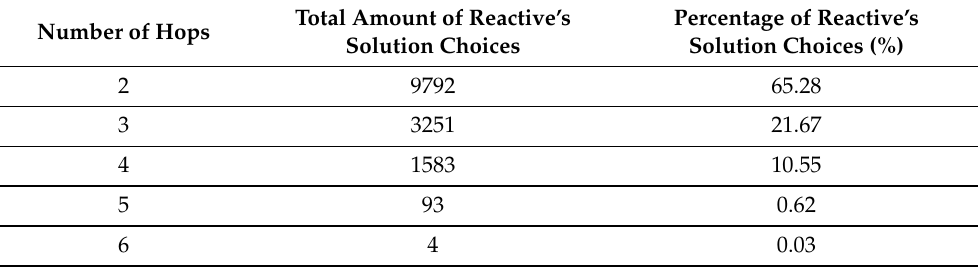
Table 6. Number of hops included on each reactive’s solution path choice, over 1500 interest-data exchanges.